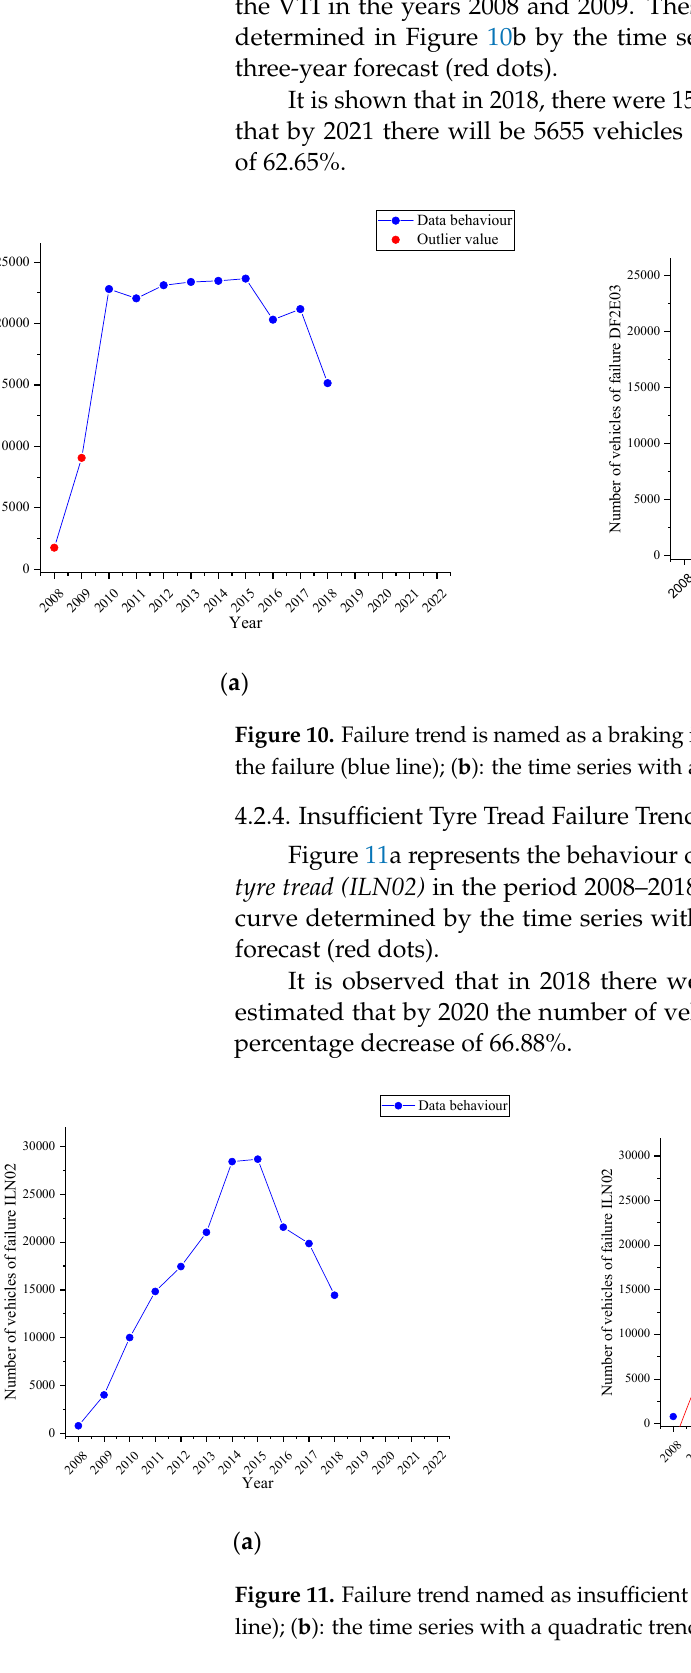
( b ) Figure 9. Failure trend named as vertical alignment of the driver headlight (AVFC09). ( a ): behaviour of the failure (blue line); ( b ): the time series with a quadratic trend (red line) and the forecast (red